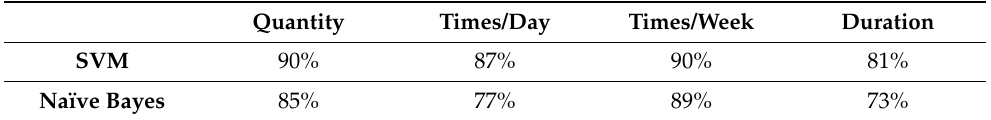
Table 1. Directions of use parsers accuracy.